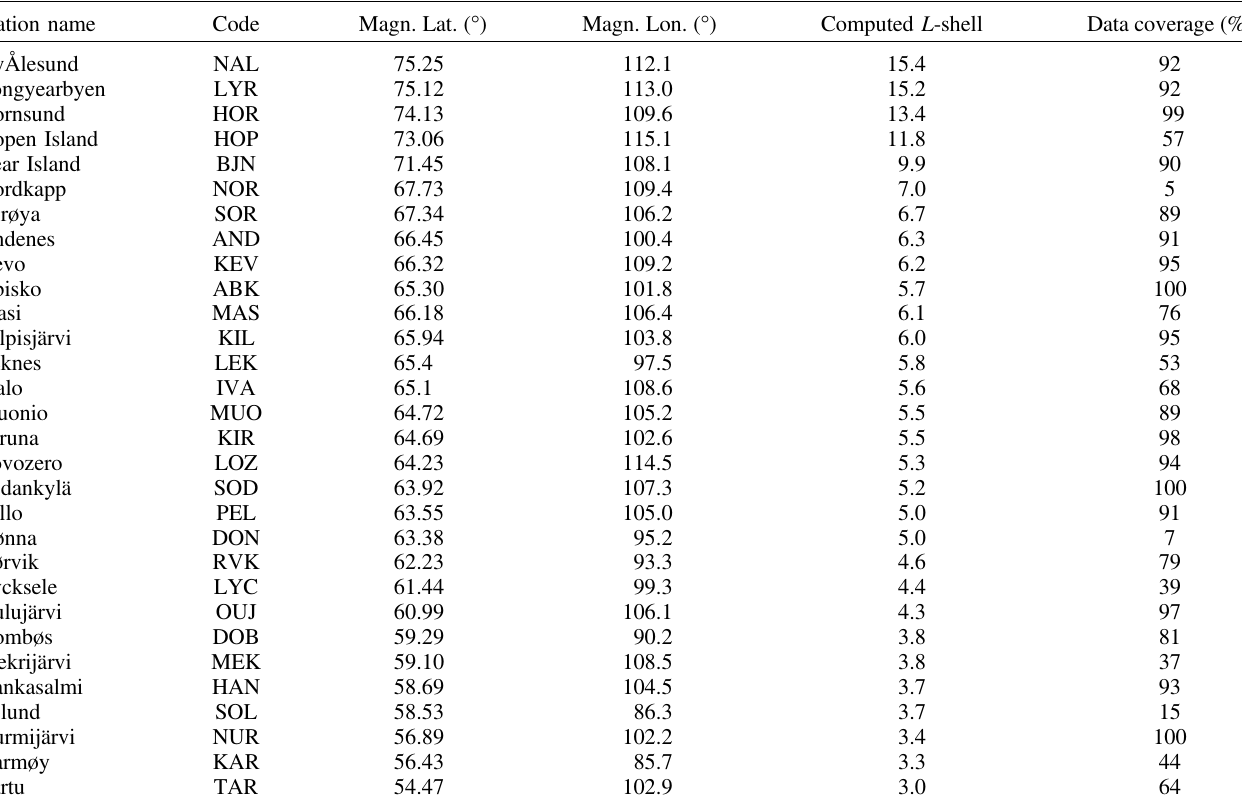
Table 1. Magnetometer data from IMAGE network that is used for computing ground Pc5 pulsation power. Station